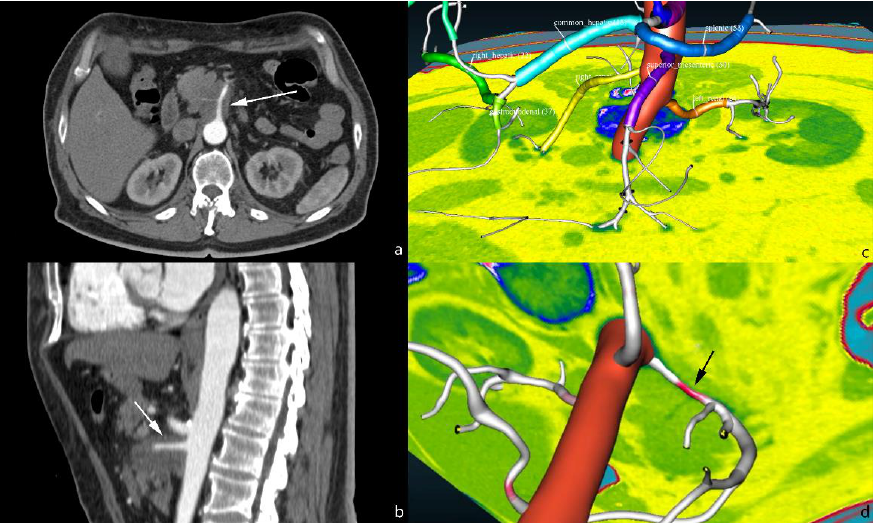
Figure 5. Axial ( a ) and sagittal ( b ) CT scan showing the infiltration of the superior mesenteric ar- tery by pancreatic adenocarcinoma (white arrow). 3D view of automatic vessel labelling ( c ). Highlighting of the stenosis on the superior mesenteric artery in red ( d , black arrow). The software may be configured to automatically output the length and entity of stenosis due to the tumour infiltra- tion.